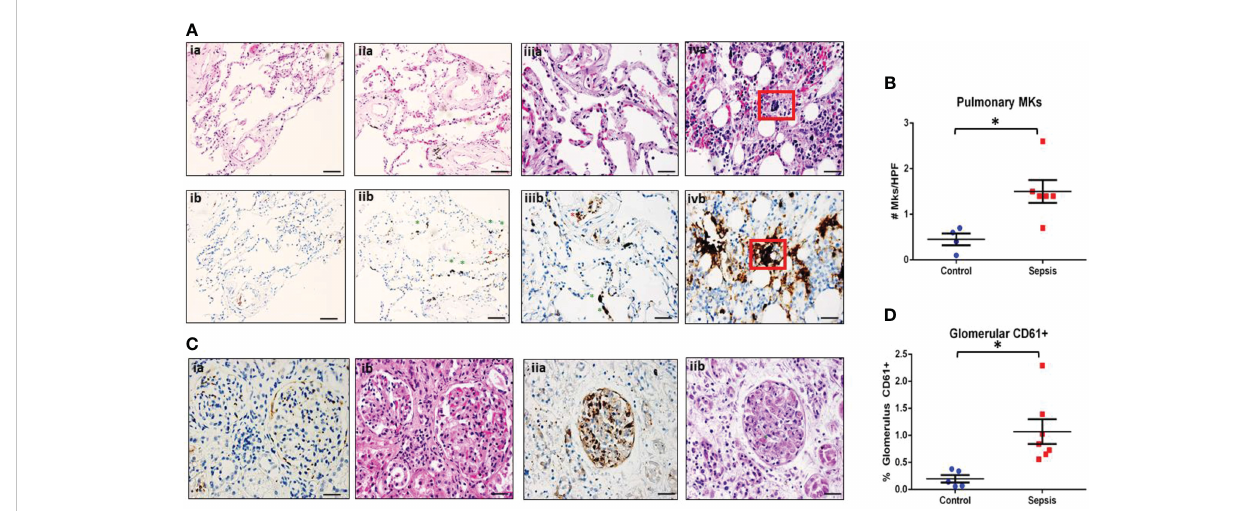
FIGURE 1 MKs are increased in peripheral organs during sepsis. Autopsy pathology samples from patients that died from sepsis were evaluated for MKs. (A) MKs in the lungs were de fi ned as large cells with dark, homogenous CD61+ staining (brown). An example of a lung image from a patient that died from heart disease as a negative control is shown in panel ia (hematoxylin and eosin, H&E) and ib (CD61). No MKs were observed in these images. A representative image of two lung images from a patient that died from sepsis are shown in panel iia/iiia (H&E) and iib/iiib (CD61), showing multiple MKs (green asterisks). Platelet staining is also noted (red asterisks). In some cases, a large dark staining basophilic nucleus can be seen in the H&E in the area of the CD61 staining. This was not always the case, which may be due to sectioning and imaging of slightly different planes. This also suggests that CD61 may be more accurate when counting MKs than H&E. A sample of bone marrow from a sepsis patient is shown in panel iva (H&E) and ivb (CD61) as an example of an MK with CD61 staining as a positive control (red box). (B) Glomeruli were evaluated for the presence of increased CD61 staining. Individual MKs could not be reliable counted within the glomeruli, therefore percent of CD61 stain/glomeruli was evaluated. A glomerulus from a control patient is shown in panel ia (CD61) and ib (H&E), with minimal CD61 staining. This is in contrast to a glomerulus from a patient with sepsis and disseminated intravascular coagulation (DIC), which has much higher amounts of CD61 staining along with microvascular thrombi within the glomerular capillaries (green asterisk). Upon evaluation, there was signi fi cantly higher pulmonary MKs (C) and glomerular CD61 staining (D) in the sepsis patients as compared to control. Signi fi cance is calculated via student t-test with signi fi cance being de fi ned as p < 0.05 (*). Scale bars are: Ai-ii, 100 m m, Aiii-iv and C, 50 m